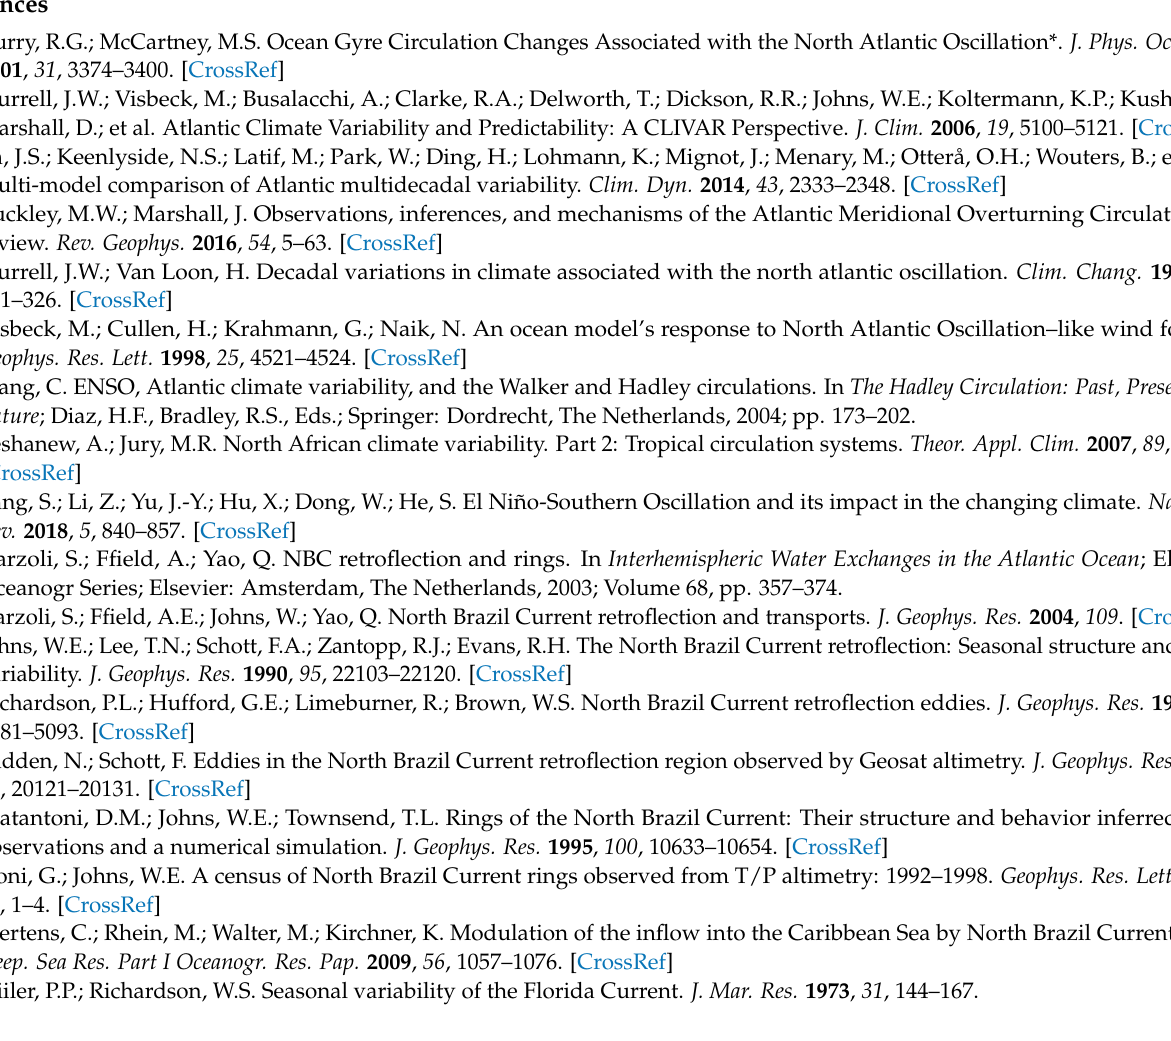
Figure A2. Intercomparison of monthly 50–100 m meridional currents averaged over the AMW index area (15–22° N, 78–61° W), a validation that offers context. ORA5 and GODAS are ECMWF and NCEP ocean reanalyses, respectively. Here, Atlantic inflow to the Caribbean is –V.